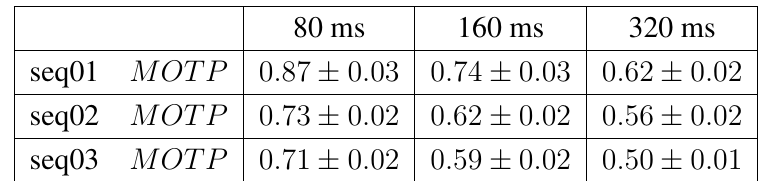
Table 3. Baseline MOT P ( m ) results for all sequences, different frame sizes and microphone setup